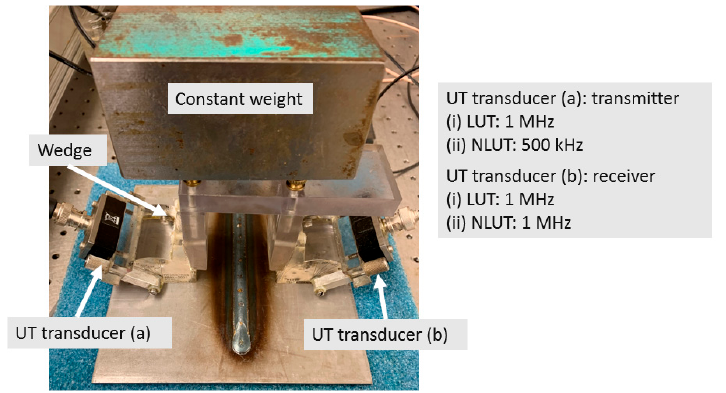
Figure 3. Experimental setups of LUT (Linear Ultrasonic Testing) and NLUT (Nonlinear Ultrasonic Testing).